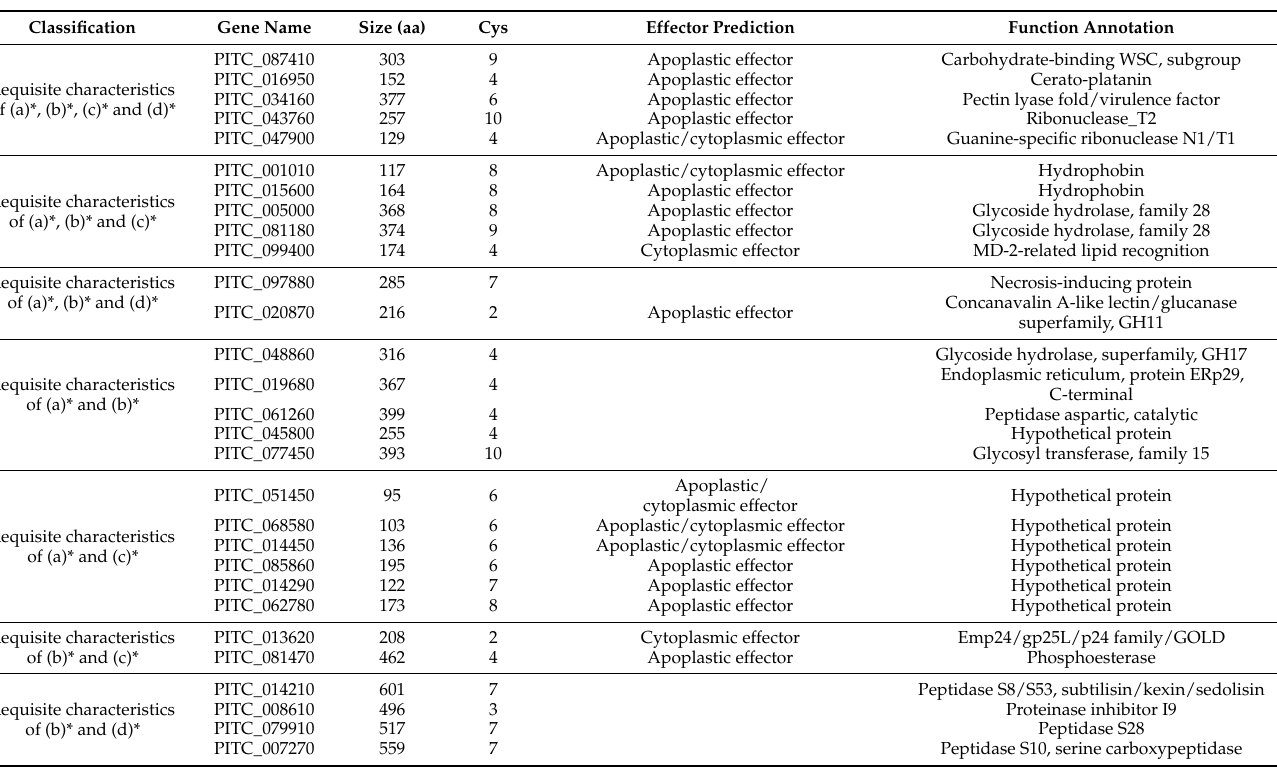
Table 1. Twenty-nine candidate effector proteins of P. italicum